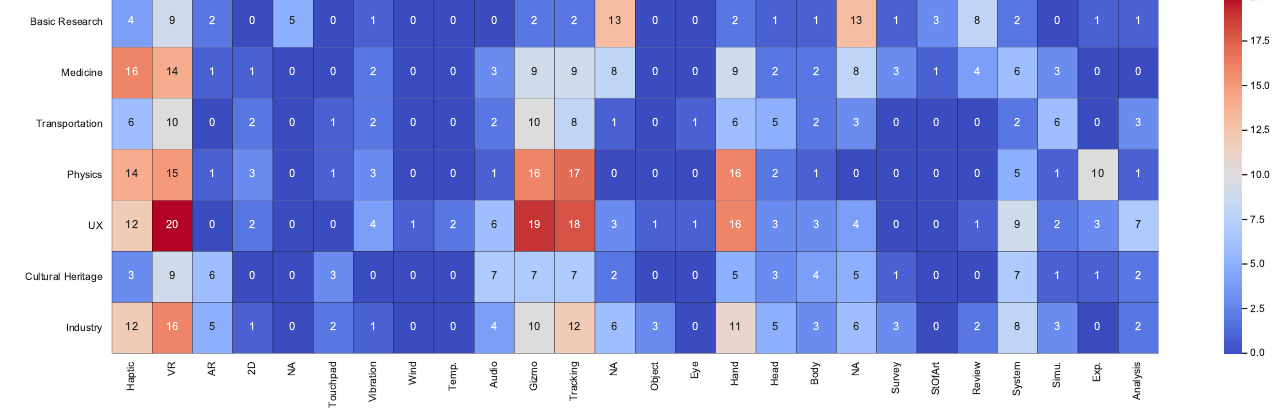
Figure 3. Frequency of types of interaction per specific